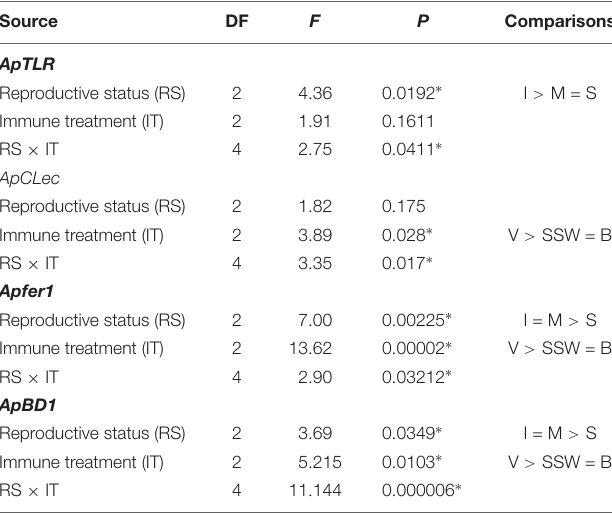
TABLE 2 | Two-way ANOVAs to compare transcriptional levels of immune genes between Argopecten purpuratus scallop at different reproductive status and immune